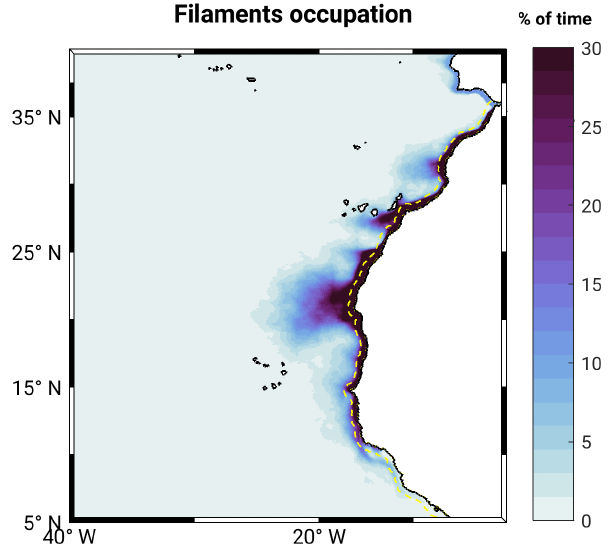
Figure B12. Percentage of the total time in which each grid node is occupied by a filament, according to our filament identification algorithm. The boundary corresponding to the first 50km from the northwestern African coast has been highlighted with a dashed yellow line. Regardless of the fact that this range of distances is often covered by the filament mask, alongshore currents are dominant in this